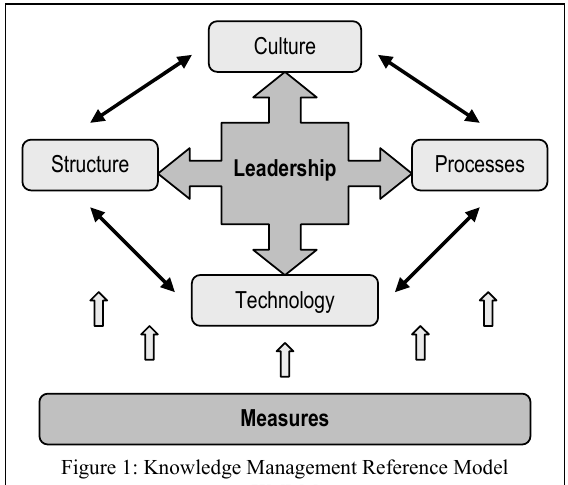
Figure 1: Knowledge Management Reference Model KMRM